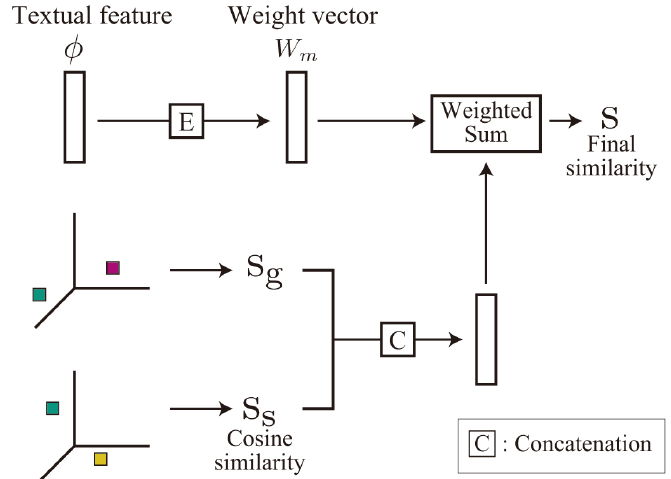
Figure 3. Similarity